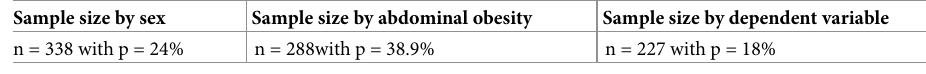
Table 1. Sample size calculation by using different variables [9]. Sample size by